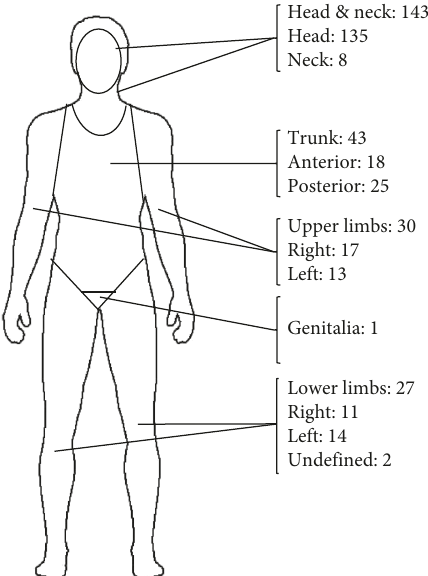
Figure 1: Distribution of basal cell carcinoma tumours on the body ( n � 244, n � 2 location not stated).